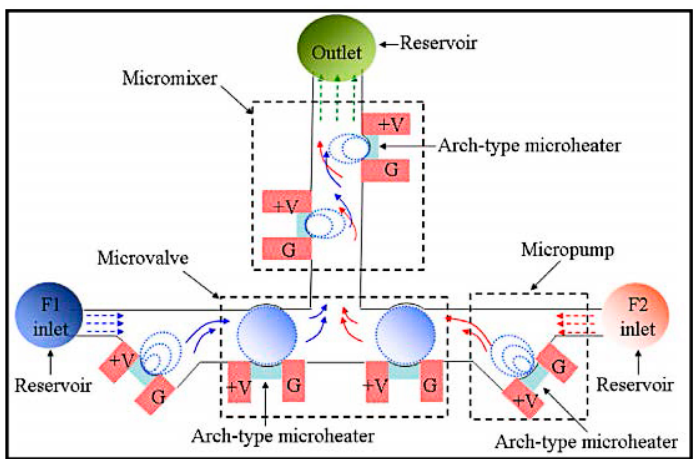
Figure 8. Schematic of the microfluidic system including microchannel, micro-valve, micro-pump and micromixer. Reproduced with permission from [61].